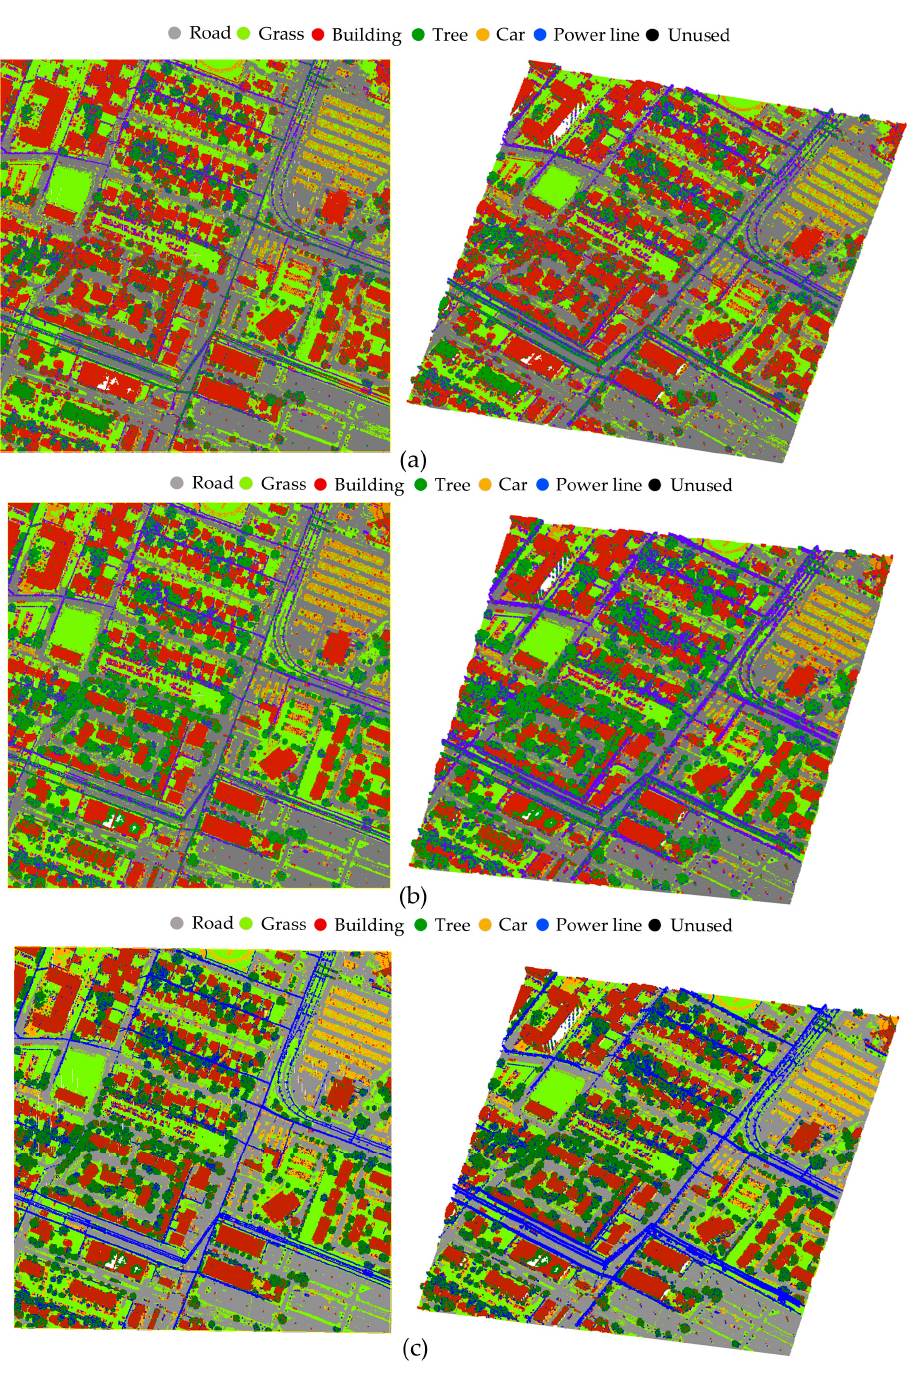
Figure 6. Results of three experimental classifications based on different methods: ( a ) method (a); ( b ) method (b); and ( c ) method (c).